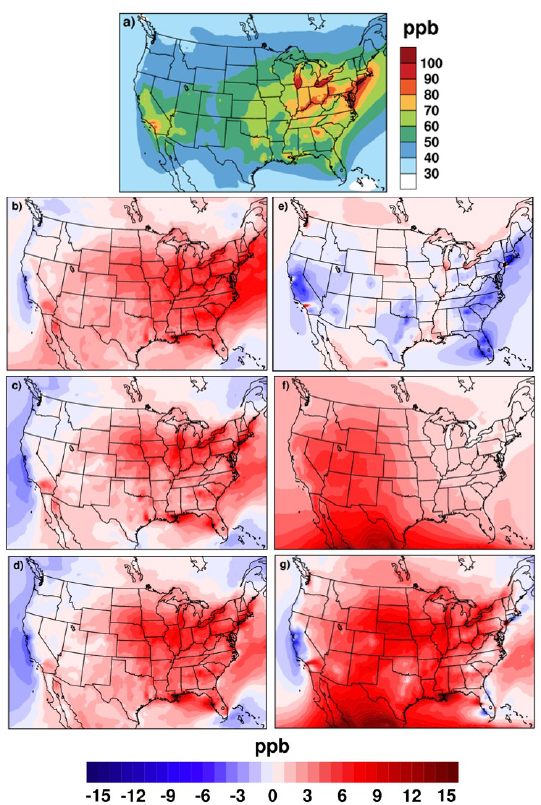
Figure 12. (a) Current decade base case daily maximum 8h ozone average concentrations for five summers in the 2000s; spatial distribution; and regional effect on maximum 8h ozone due to (b) changes in meteorology (Simulation 1–Simulation 0); (c) changes in meteorology and biogenic emissions (Simulation 2– Simulation 0); (d) changes in meteorology, biogenic emissions, and land use (Simulation 3–Simulation 0); (e) changes in US an- thropogenic emissions (Simulation 4–Simulation 0); (f) changes in global anthropogenic emissions (Simulation 5–Simulation 0); and (g) all the changes above combined (Simulation 6–Simulation